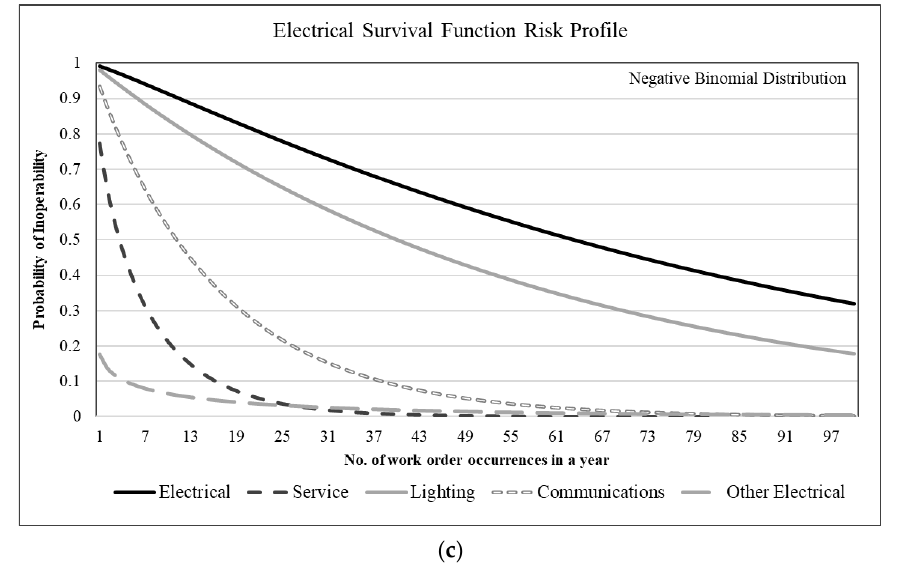
Figure 11. Survival Function Risk Profile for UPM Work Orders: ( a ) HVAC; ( b ) Plumbing; and ( c ) Electrical.